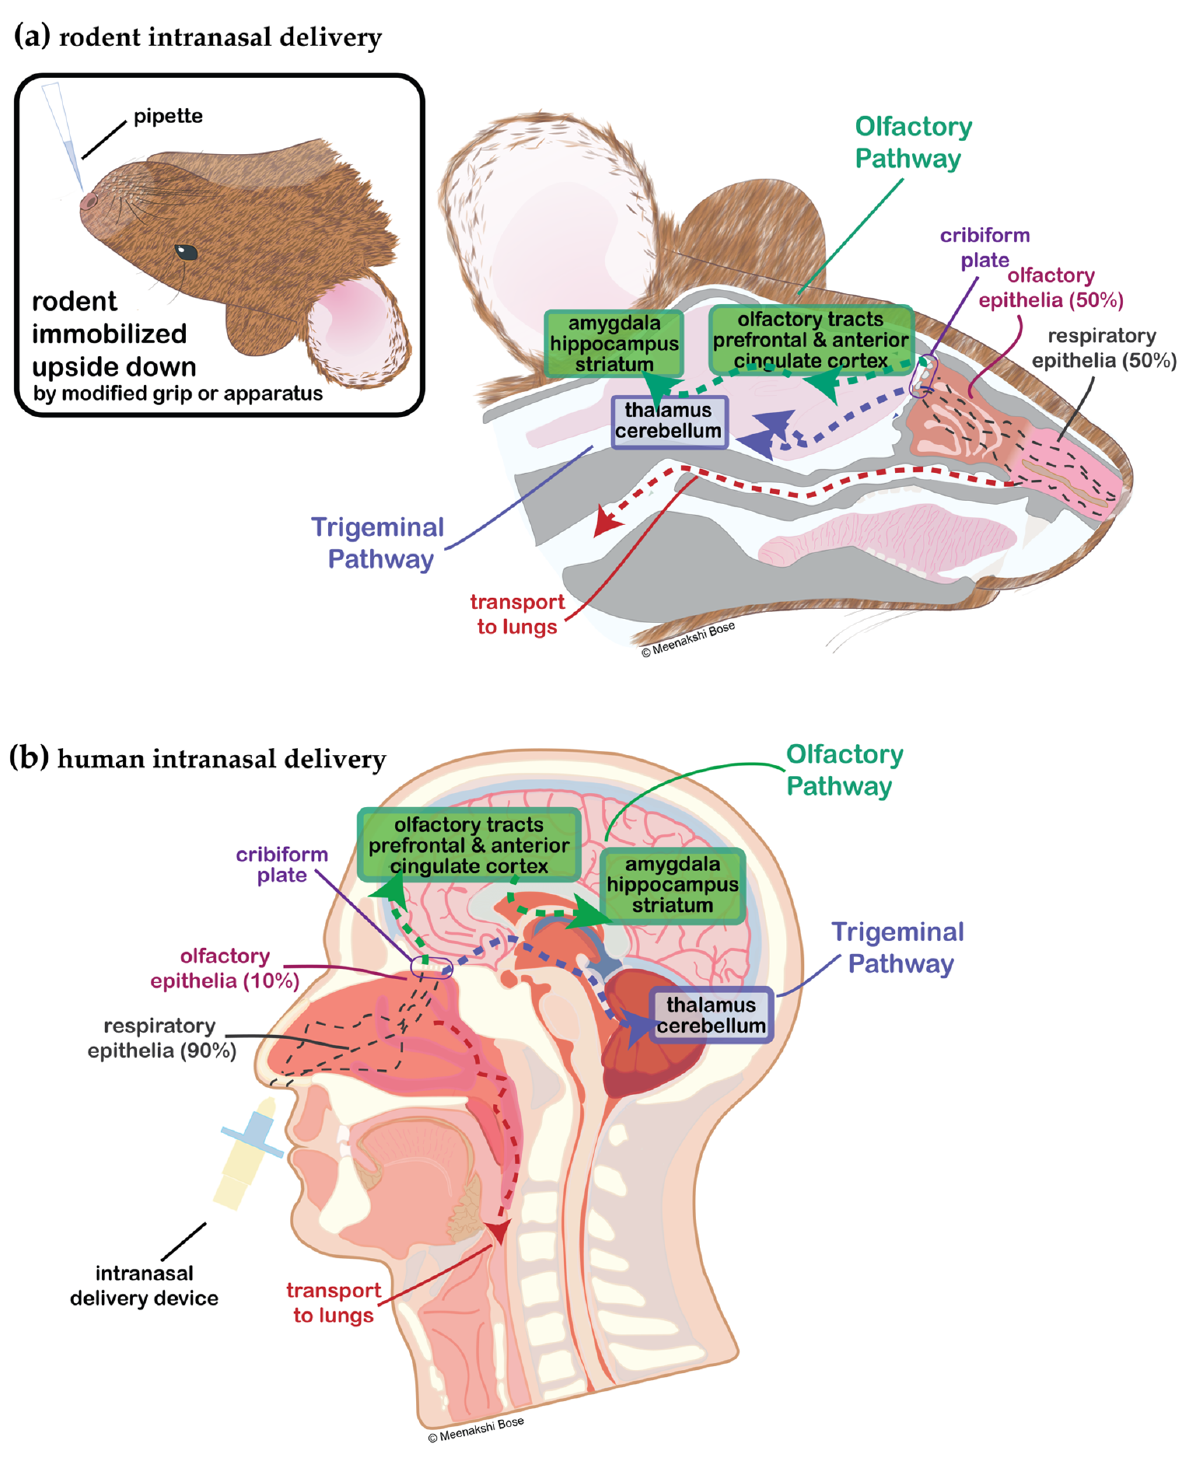
Figure 1. Diagrammatic representation of intranasal administration in ( a ) rodent and ( b ) human. ( a ) Rodent is held upside down in a modified one-handed grip and low a volume-high concentration peptide drug is delivered to awake (non-anesthetized) animals [24]. Rodent nasal epithelium is 50% respiratory epithelia and 50% olfactory epithelia, whereas ( b ) human is 90% respiratory and 10% olfactory. With human administration of intranasal drugs targeted to the CNS, a variety of nasal delivery devices are utilized in clinical trials to target delivery to the upper nasal cavity and olfactory epithelia, maximizing nose-to-brain transport across the cribiform plate